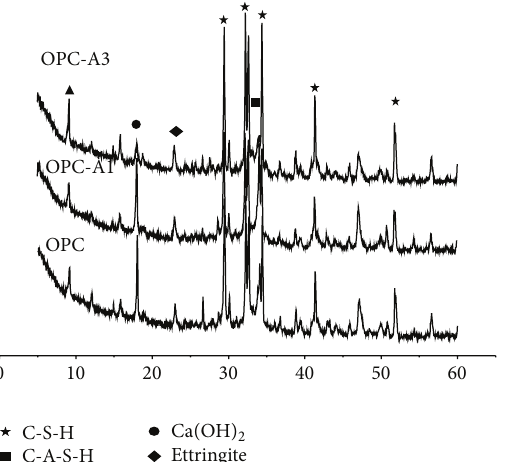
Figure 11: Specimen incorporating calcium acetate (3 days).